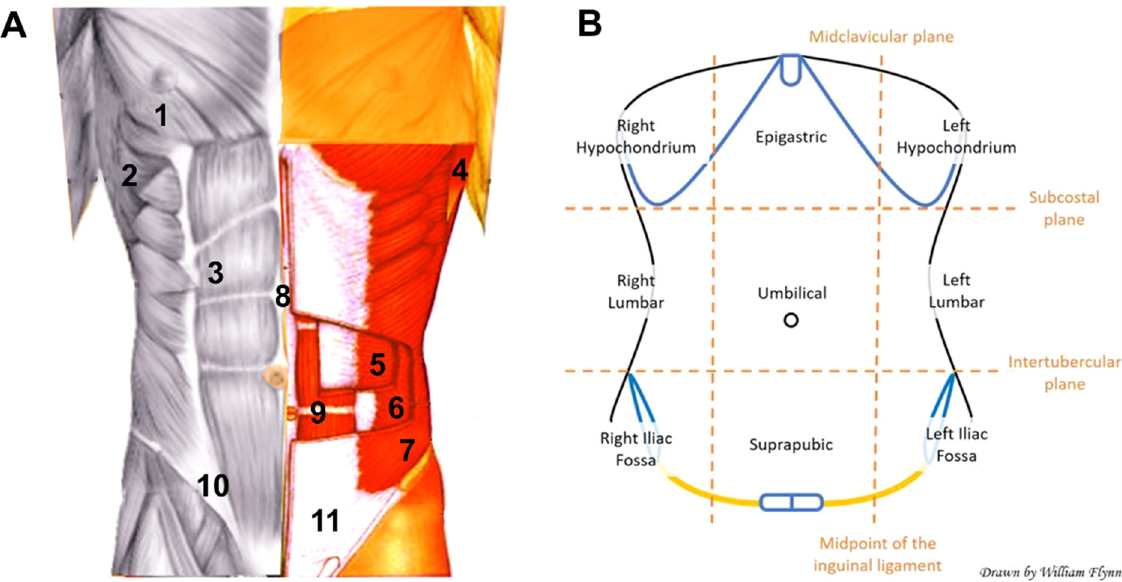
Figure 1. Anatomical structure of the anterior abdominal wall. ( A ) Principal muscles (1 pectoralis; 2 serratus anterior; 3 rectus abdominis; 4 latissimus dorsi; 5 transverse abdominis; 6 internal oblique; 7 external oblique) and other relevant components (8 linea alba; 9 tendinous intersection; 10 inguinal ligament; 11 external oblique aponeurosis). Original image by Scott Dulebohn [2] adapted with permission from StatPearls Publishing (Creative Commons Attribution 4.0 International License). ( B ) Diagram illustrating the different anatomical regions of the anterior abdominal wall. Original drawing by William Flynn [2] reproduced with permission from StatPearls Publishing (Creative Commons Attribution 4.0 International License).